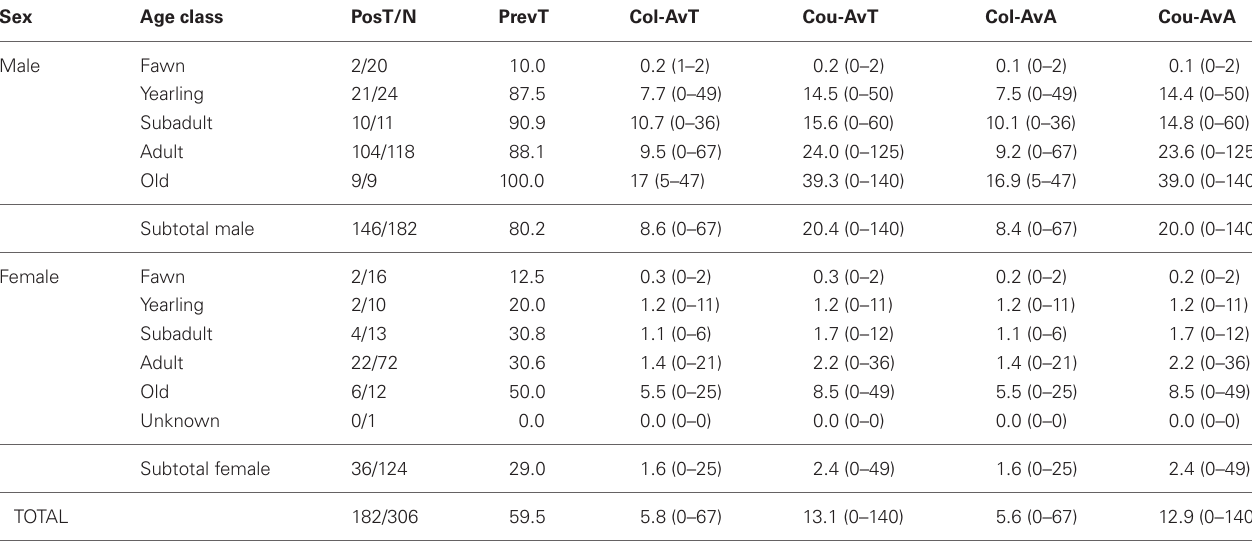
Table 3 | Data on the number of tick parasitized deer (PosT) with respect the total number (N) of analyzed deer throughout sex and age class.